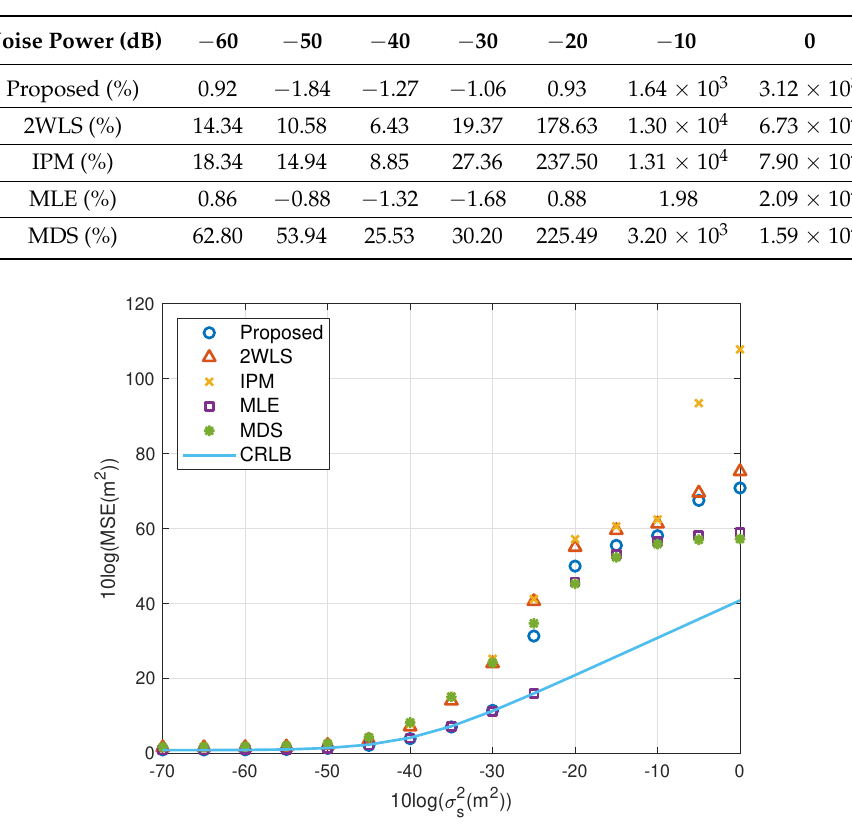
Table 3. MSE increasing percentage (far source).